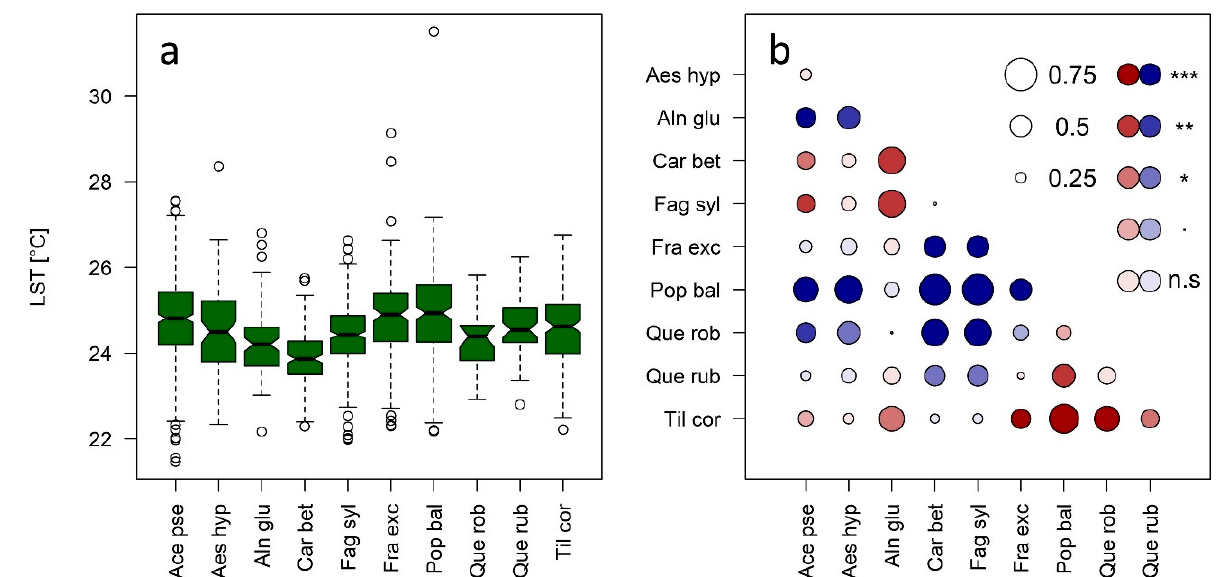
Figure 4. ( a ) Observed species-specific differences obtained from gyrocopter LST data with a pixel size of 0.4 m, ( b ) results from the spatial autocorrelation (SAC) model showing a pairwise comparison of fine-scale tree species surface temperatures as obtained from the SAC model (gyrocopter data, 0.4 m pixel size; reference species at the x -axis—higher surface temperatures of tested species compared to the reference species in red, lower temperatures in blue). The diameter of circles is related to the magnitude of species difference in ◦ C and the color gradient indicates the level of significant species differences (n.s. p > 0.05, * p < 0.05, ** p < 0.01, *** p < 0.001).